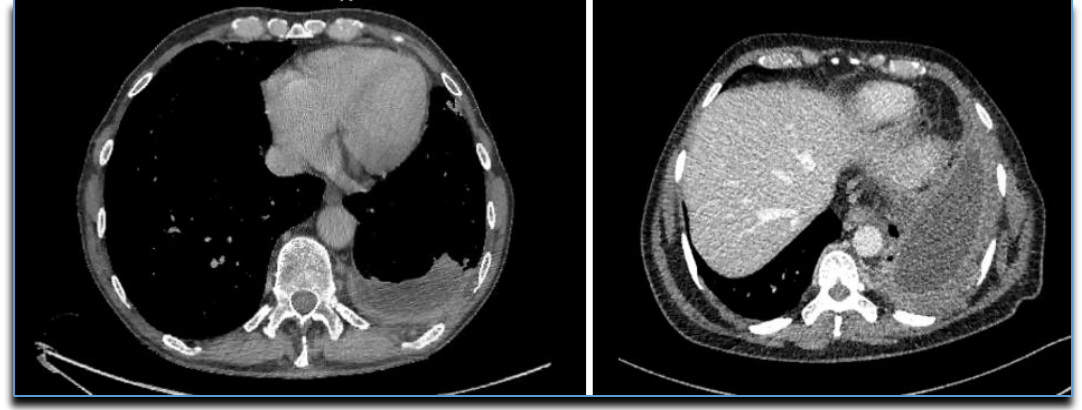
Figure 8. CTs showing the “Split Pleura” sign.